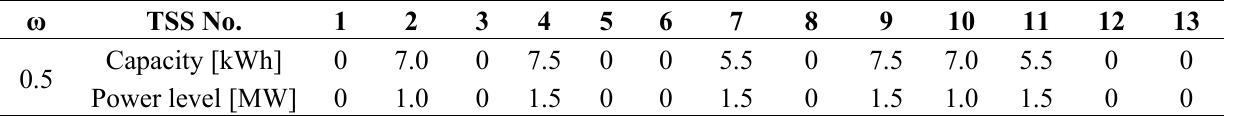
Table 5. Optimized schemes of moderate traffic volume.